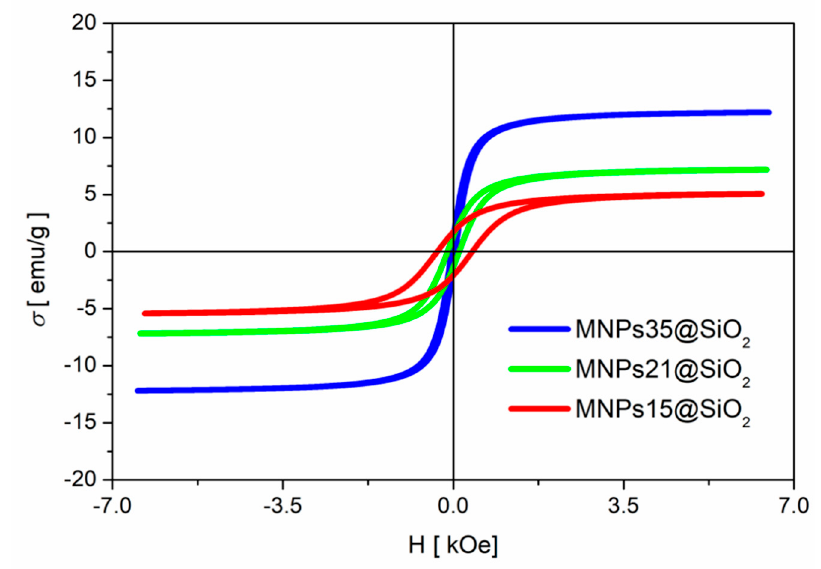
Figure 3. Magnetization curves of the magnetic nanocomposites.